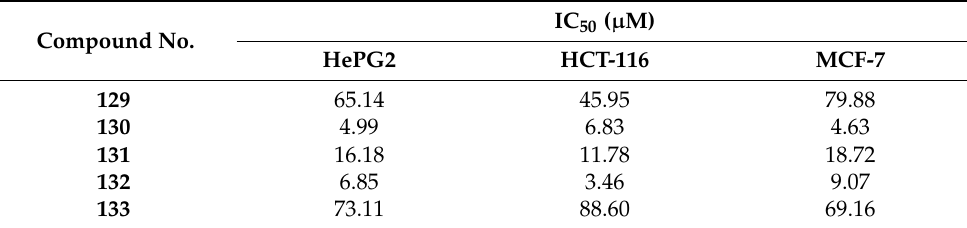
which showed activity in the MTT growth inhibition assay against five cancer cells lines: MCF ‐ 7, A549, SiHa, COLO205 and HePG2 cells. Compound 134 ( b ) was found to active against A549, SiHa, COLO205 and HePG2 cell lines with IC 50 values of 4.94, 4.54, 4.98 and 2.09 μ M, respectively, and was non ‐ toxic against normal cells. The structure of pyrazoline ‐ pyrazole hybrids is given in Figure 123 and in vitro IC 50 of compounds 134 ( a – e ) against cancer cell lines is shown in Table 110 [201].